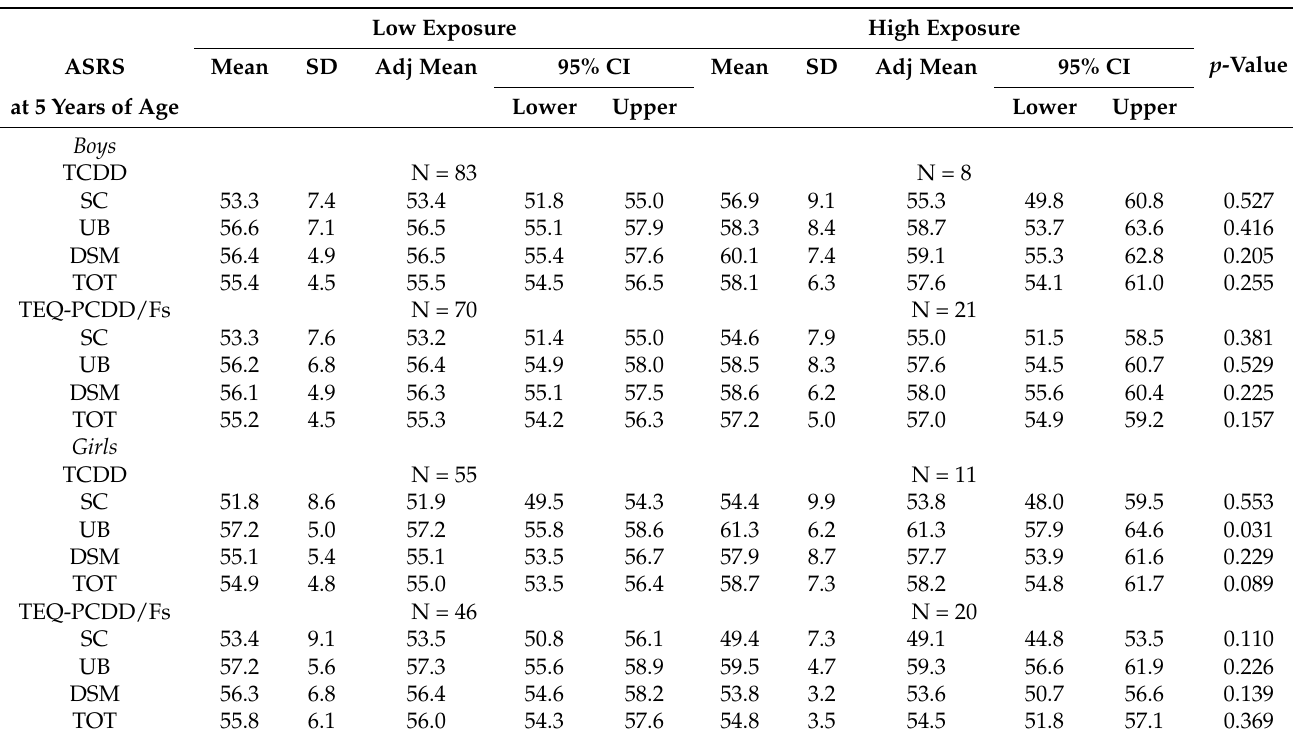
Table 5. Adjusted comparisons of ASRS scores at 5 years of age between high and low expo- sure groups.